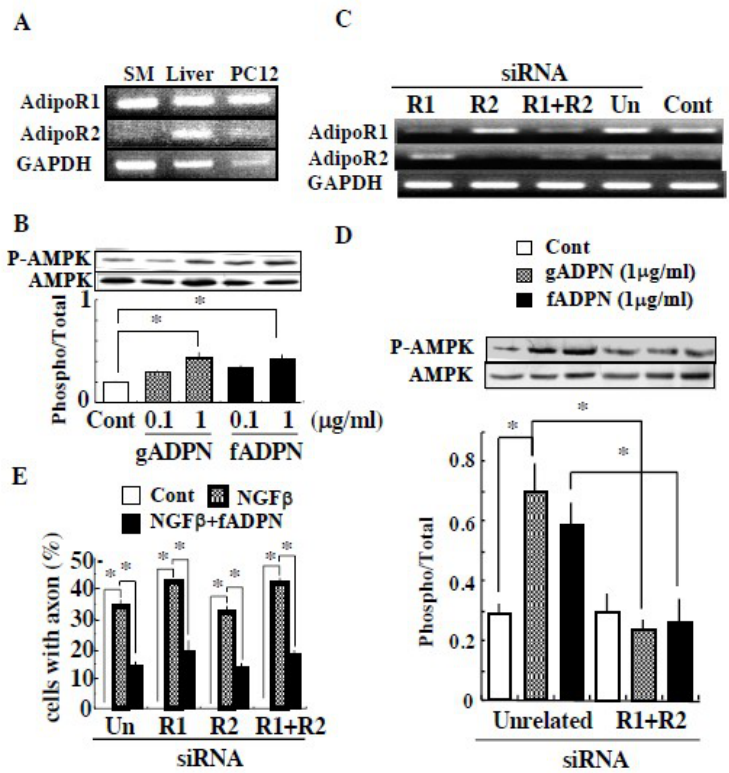
Figure 3. Adiponectin suppressed NGF β -induced neurite outgrowth independently of its Figure 3 . Adiponectin suppressed NGF  -induced neurite outgrowth independently of its receptor